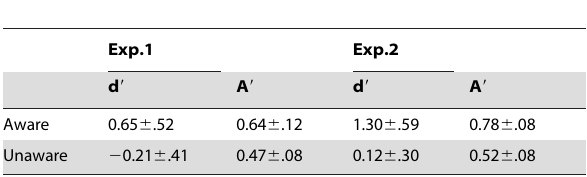
Table 1. d 9 and A 9 scores for Experiment 1 & 2.